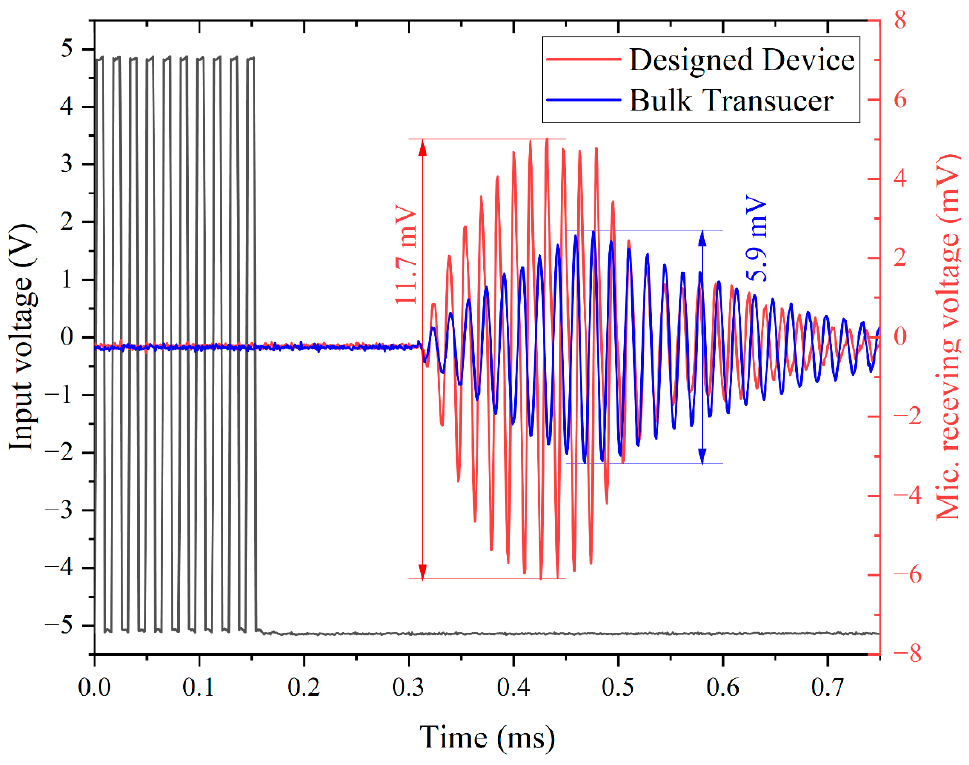
Figure 6. Acoustic time-domain characterization: acoustic measurements use a designed PMUT array and a calibrated reference microphone. The PMUT array is excited by 10-cycle square continue wave with driving voltage of 10 𝑉 𝑝𝑝 . The sound pressure of 20.35 Pa (120 dB SPL, red) is measured at 10 cm, which is 9.7 Pa (114dB SPL, blue) for the bulk transducer.